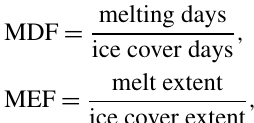
Figure 3. Meteorological and satellite measurements along a sea ice buoy in the Weddell Sea from 1 September 2014 to 1 May 2015. (a) Snow depth (cyan line), daily maximum T air (pink line) and SIC (olive line); the brown line represents T air = 0 ◦ C. (b) T b line), T b (dark green line), DAV36 (light green line) and DAV36 ice (red line); the black line represents DAV = 10K. The inset map in V36D (b) illustrates the annual mean SIC and the route of the buoy from multiyear ice to first-year ice. The black arrows indicate the cases in which melt events were recognized by DAV36 ice rather than